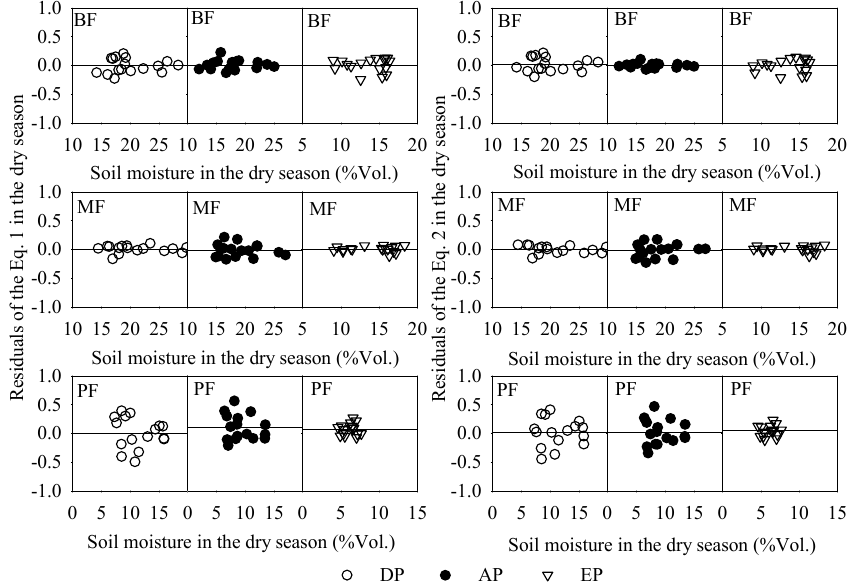
Fig. A6. Residual plots in the dry season for Eq. (1) ( R = (a 1 + c 1 M) exp (b 1 T ) ) and Eq. (2) ( R = (a 2 M 2 + c 2 M + d 2 ) exp (b 2 T ) ) under different precipitation treatments at the DNR forests. The treatments are as follows: precipitation exclusion (EP), ambient precipitation (AP), and double precipitation (DP). The forests are as follows: broadleaf forest (BF), mixed forest (MF), and pine forest